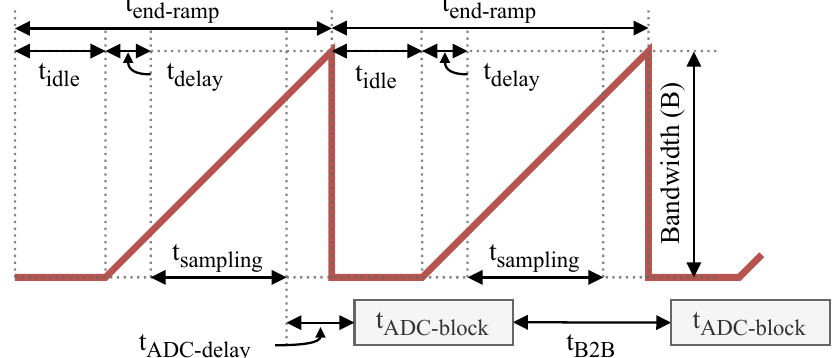
Figure 16. Simplified time diagram of the typical FMCW chirp